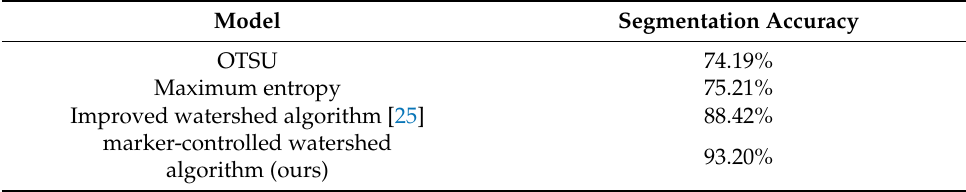
Table 4. Segmentation accuracy of